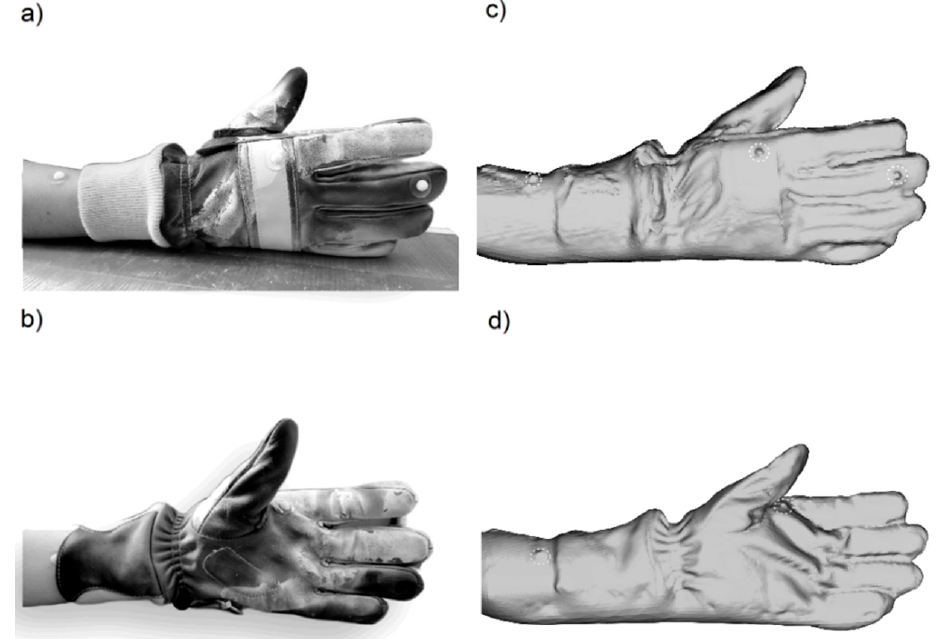
Figure 2. Hand in the protective glove with the palm rest surface used as a base for fixing the hand in the same position during the scanning and re-scanning procedure with landmarks supporting hand dimensioning ( a ) along with its image during the 3D scanning procedure ( a , b ) and corresponding 3D scans ( c , d ) with highlighted landmarks.